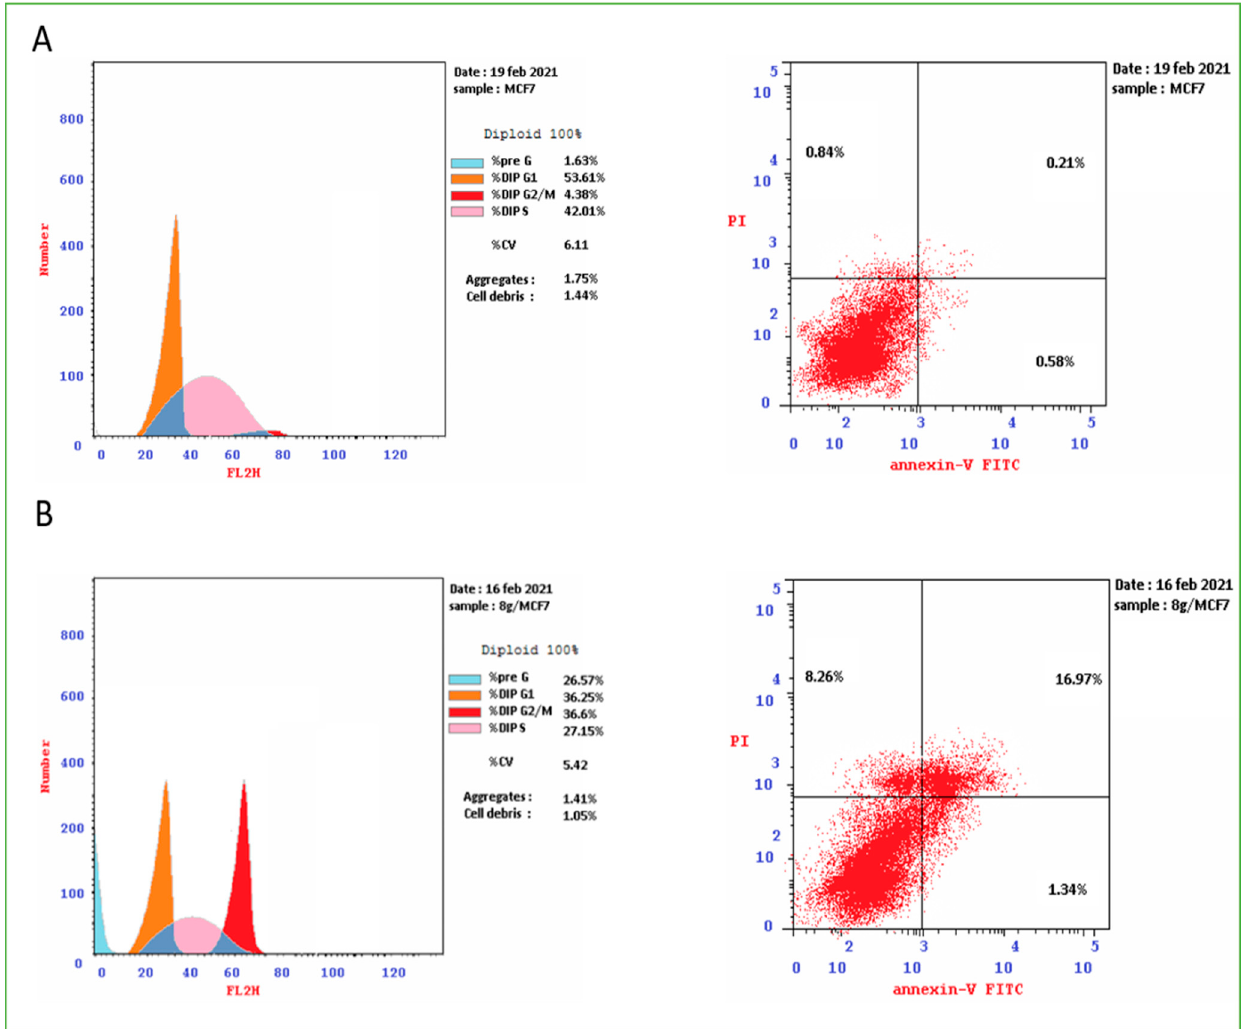
Figure 7. Cell cycle analysis and Apoptosis induction analysis using Annexin V/PI of control untreated MCF-7cell line ( A ) and 8g ( B ).